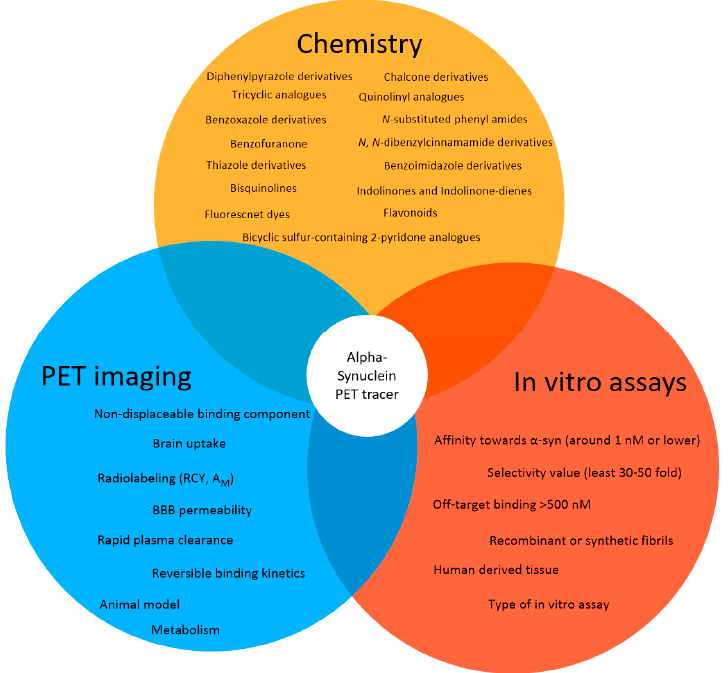
Figure 4. The approach for the development of α -syn selective PET tracers. The initial search was conducted from various sources (in Table S1, Supporting Information) in order to create an overview of compounds that have been designed and developed to image α -syn. The identified structures should be screened using criteria similar to the structures proposed by the MJFF for a successful α -syn PET tracer and are based on in vitro assays and PET imaging